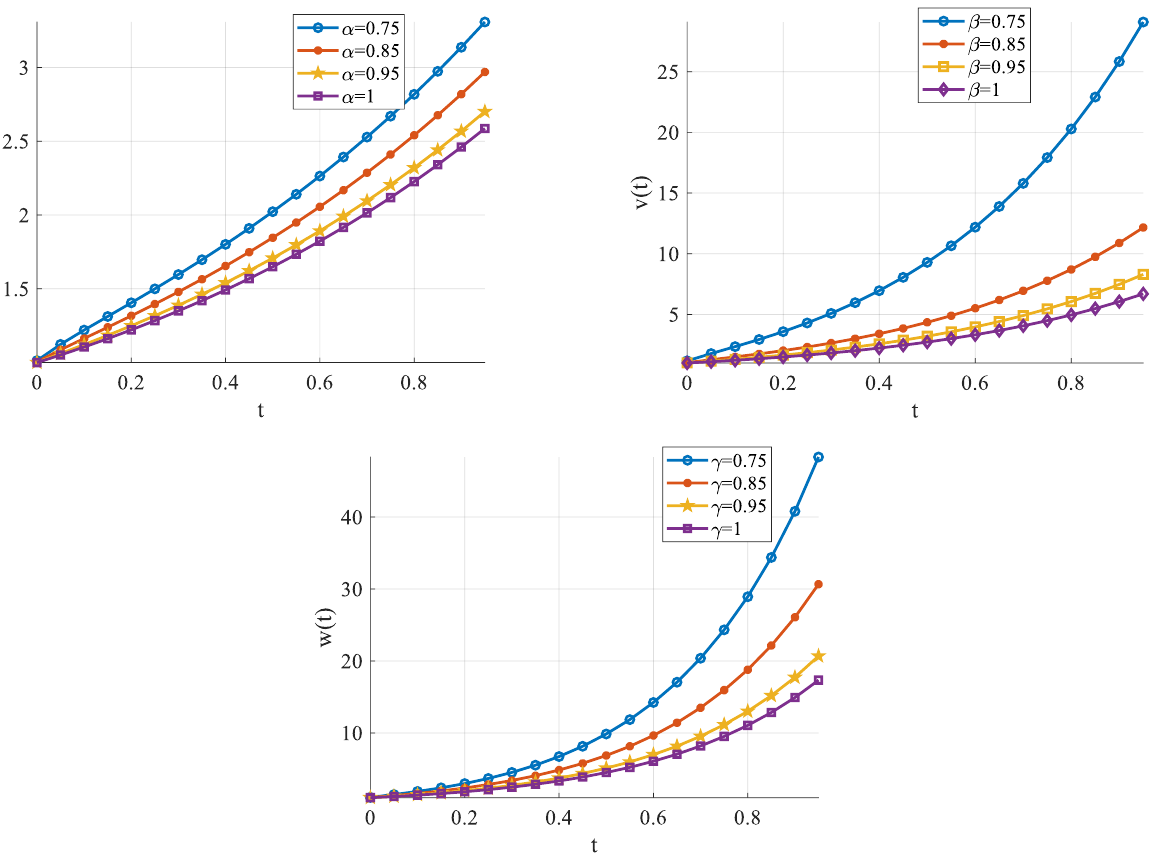
() w t () v t () u t , , and for several fractional orders for Exam-